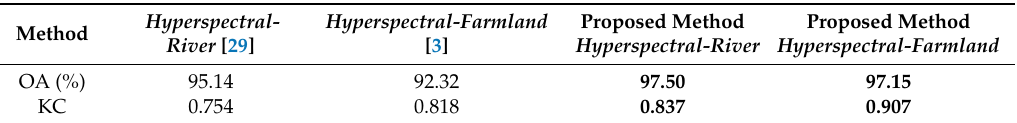
Table 14. Comparison between the accuracies of the CD methods for CD in the Hyperspectral datasets (italic characters are the name of datasets).